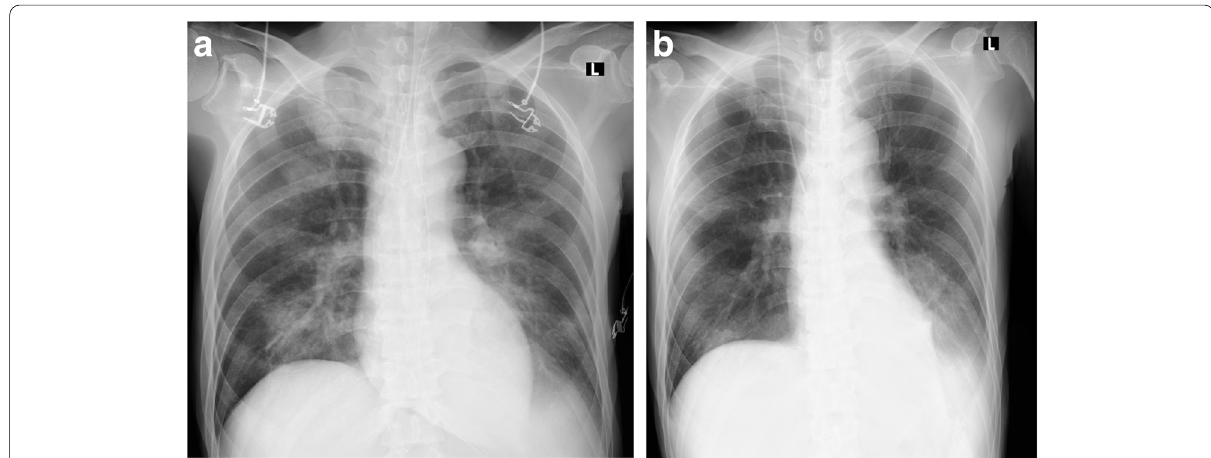
Fig. 1 Opacities in the right lower lung lobe were found immediately after surgery. Chest radiograph on POD 10. Dullness at the left costophrenic angles remained, but the opacities in the right lower lung lobe were improving after treatment. POD, postoperative